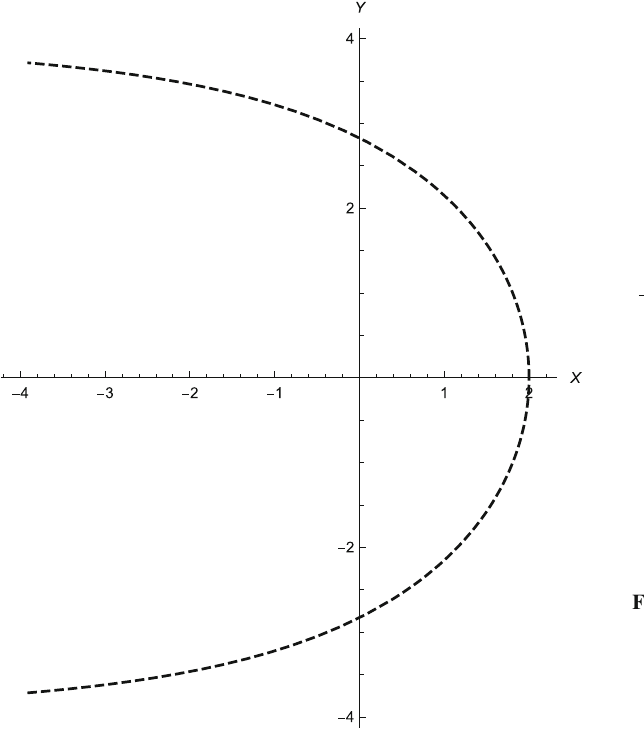
Fig. 1 2-dimensional parabolic orbit for β 0 = 1 / 2